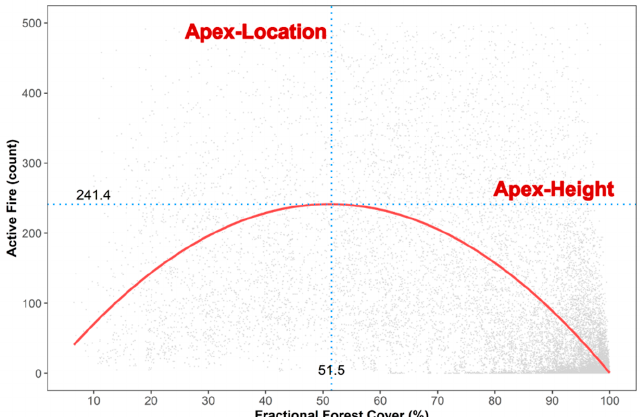
Figure 3. The quadratic relationship between forest cover and active fire counts, as derived from the GLMM analysis. Active fire counts were highest (~241) in grids with 51.5% forest cover. Horizontal blue dotted line represents the active fire apex-height and vertical blue dotted line is the forest cover apex-location. Data points (0.45° grids) are represented in grey.